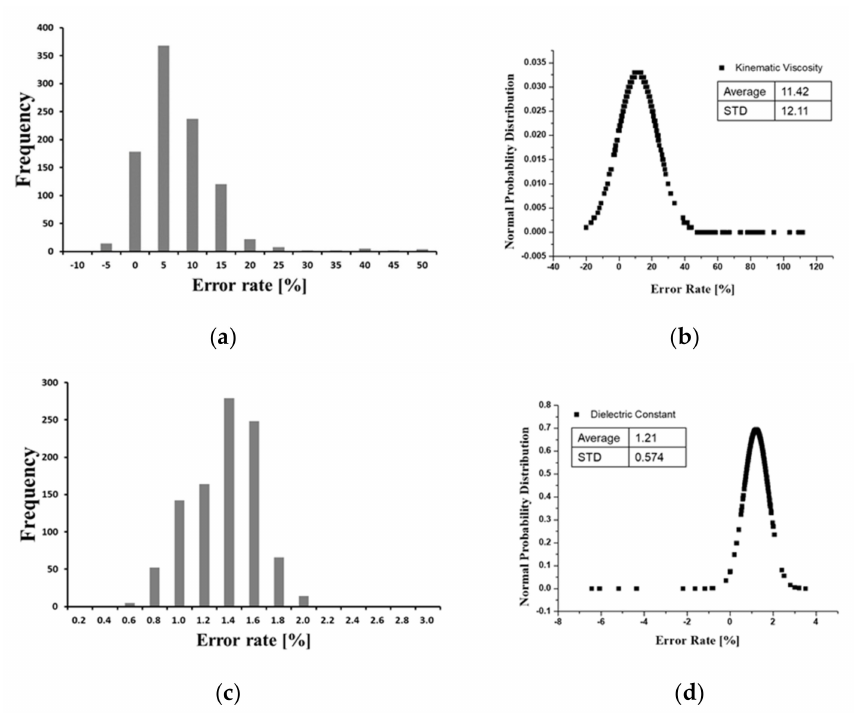
Figure 10. Analysis of error rate variability for excavator’s sensing data during one operating day. ( a ) Error rate frequency of viscosity. ( b ) Normal probability distribution of viscosity. ( c ) Error rate frequency of dielectric constant. ( d ) Normal probability distribution of dielectric constant.